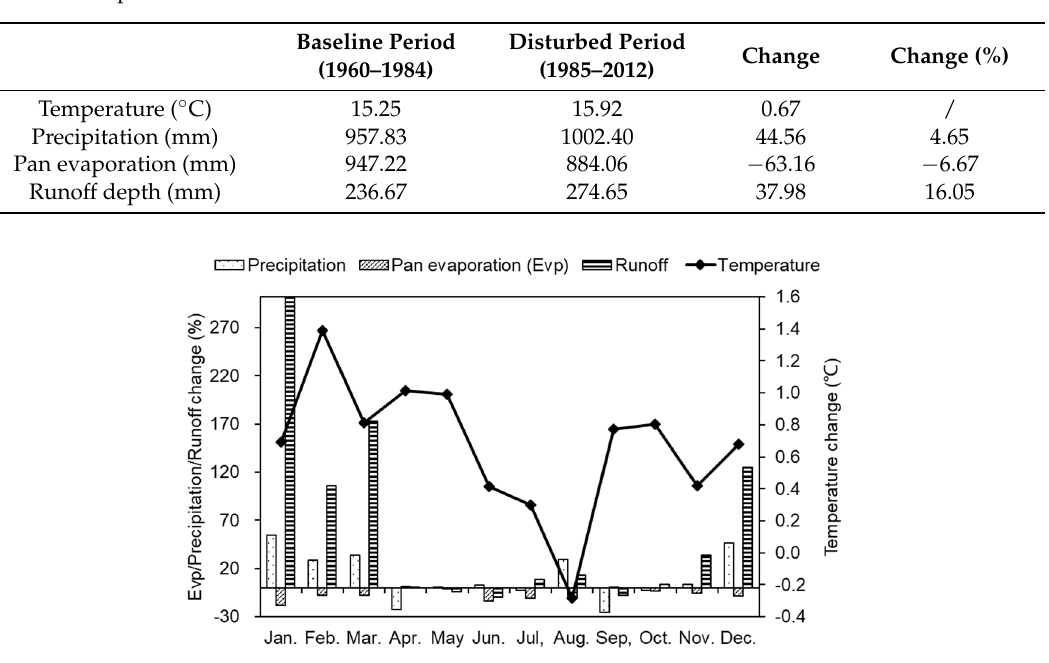
Table 3. Comparison of hydro-meteorological variables between the baseline period and the 293 disturbed period. 294